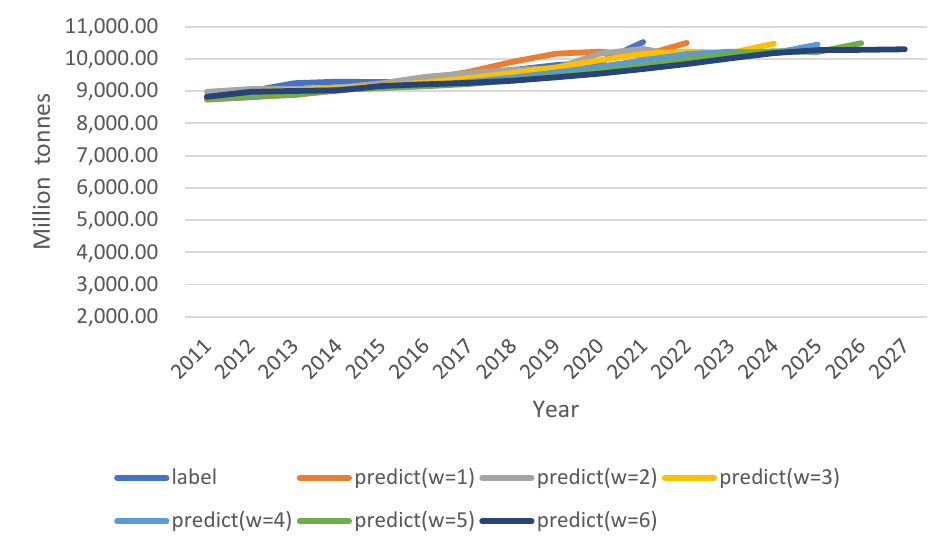
Figure 10. Comparative assessment of shallow learning models in the testing set.